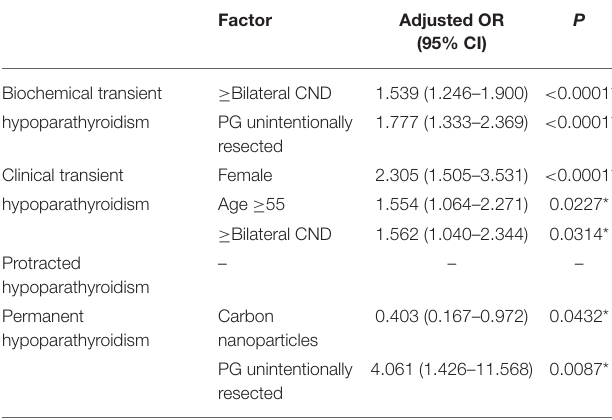
TABLE 4 | Clinical factors significantly associated with hypoparathyroidism in multivariate